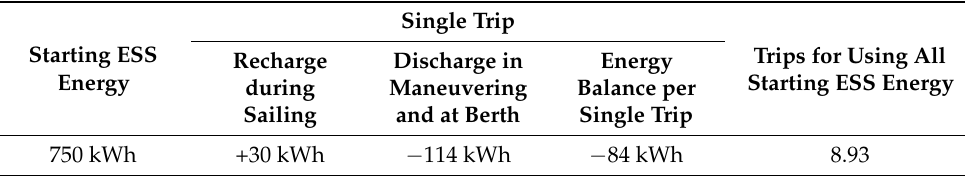
Table 6. Energy balance for case